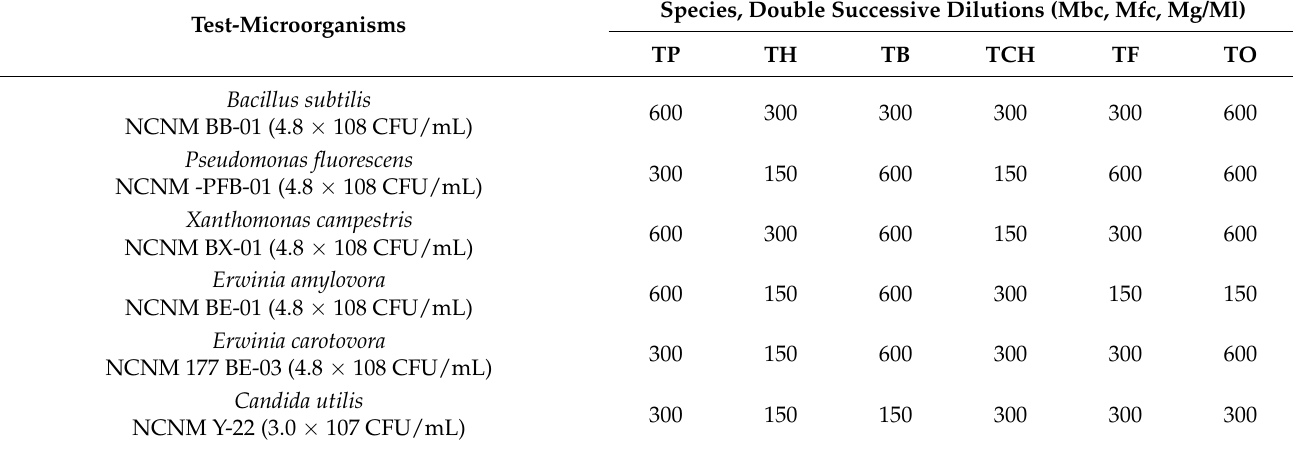
Table 5. The antimicrobial activity of the ethanolic extracts from Teucrium plants.